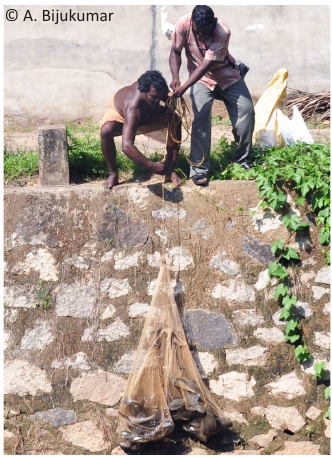
Image 4. Catch of suckermouth catfish in cast net